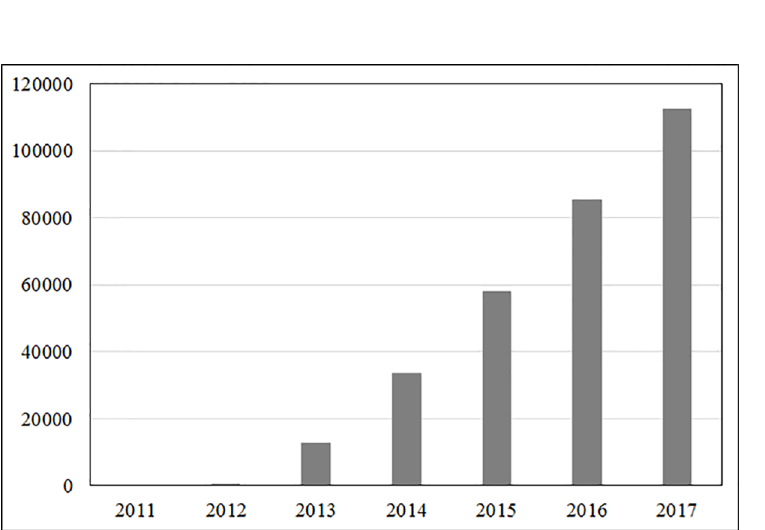
Fig 1. Distribution of CRISPR-Related Plasmids (number) by Addgene (cumulative).